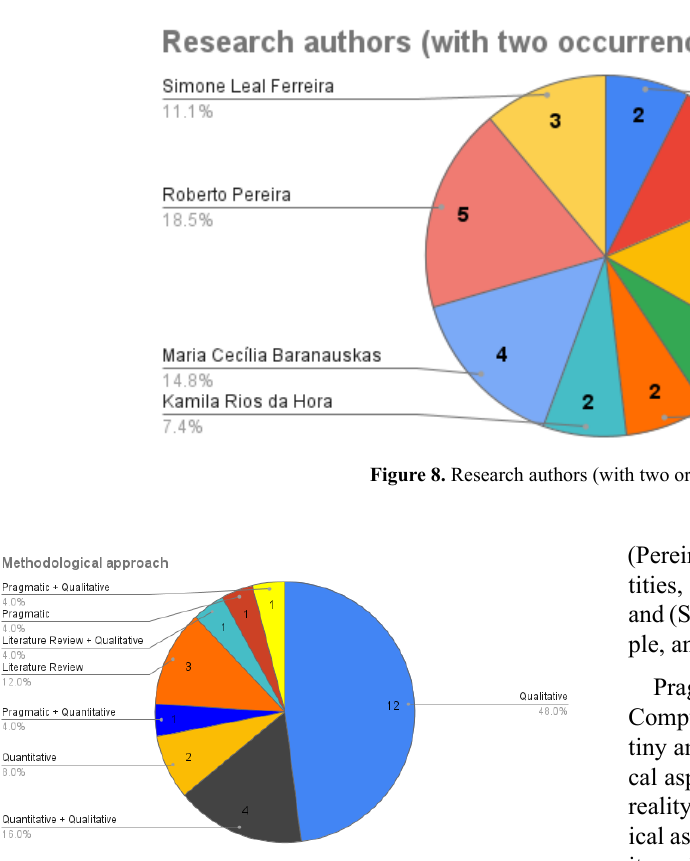
Figure 9. Methodological approach of the selected